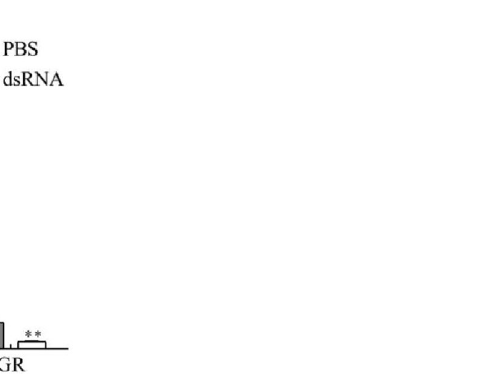
Figure 6. Effects of UV-A radiation on SOD, POD, CAT, and GR activity of H. armigera 60 min after injection with PBS or dsRNA. Data in the figure are expressed as means ± SE (* P < 0.05, ** P < 0.01,